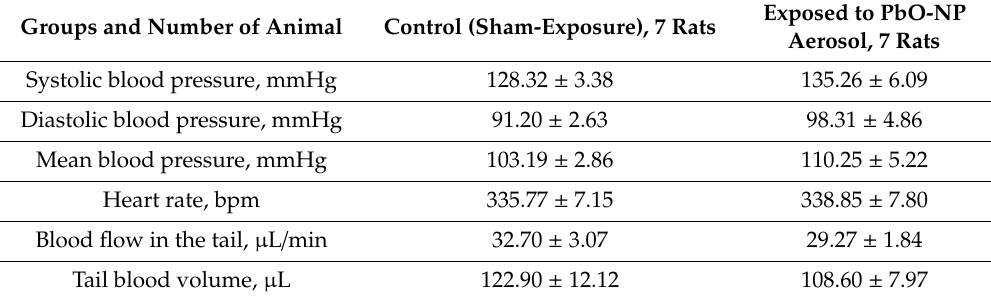
Table 4. Some hemodynamic indices of rats after repeated inhalation of lead oxide nanoparticles (x ±